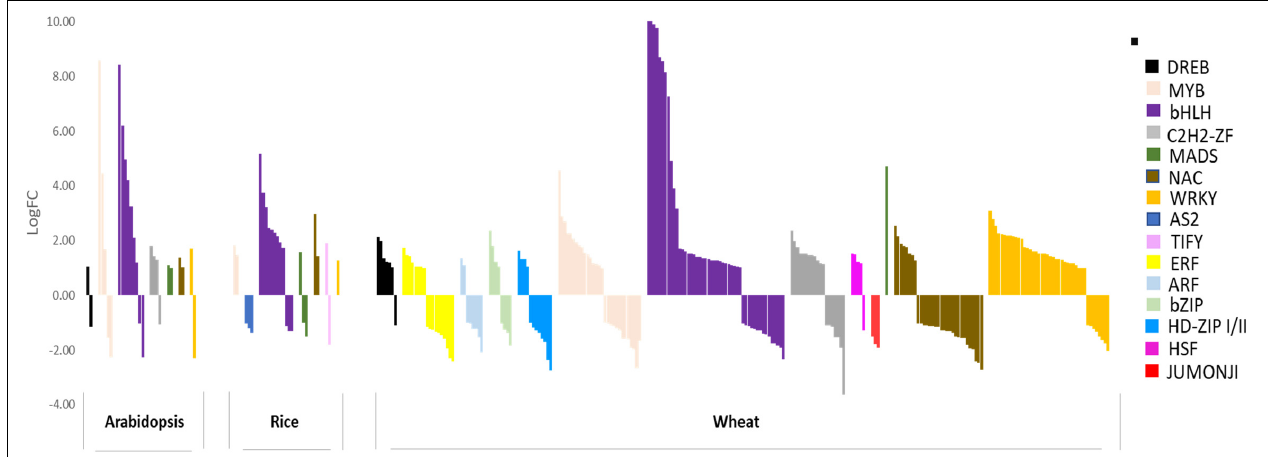
FIGURE 1 | TF subfamilies differentially expressed (DE) in response to Fe starvation in Arabidopsis , rice, and wheat. Expression bar plot representing transcription factor subfamilies differentially expressed in response to Fe starvation in Arabidopsis, rice and wheat. X -axis depicts the TF genes in respective species and Y -axis shows the log fold change (logFC) for the respective genes under Fe starvation with reference to the respective control samples. TF subfamilies are color-coded according to the legend on the right. Respective datasets were downloaded and analyzed for DEGs using the Kallisto-DESeq2 pipeline after getting high-quality, adapter trimmed reads using Trimmomatic. The DEGs for respective species were annotated for TF subfamilies using Mercator4 v2.0 (Schwacke et al., 2019) (TF subfamilies with only 1 gene DE in At and rice; less than 5 genes DE for wheat are not depicted in this